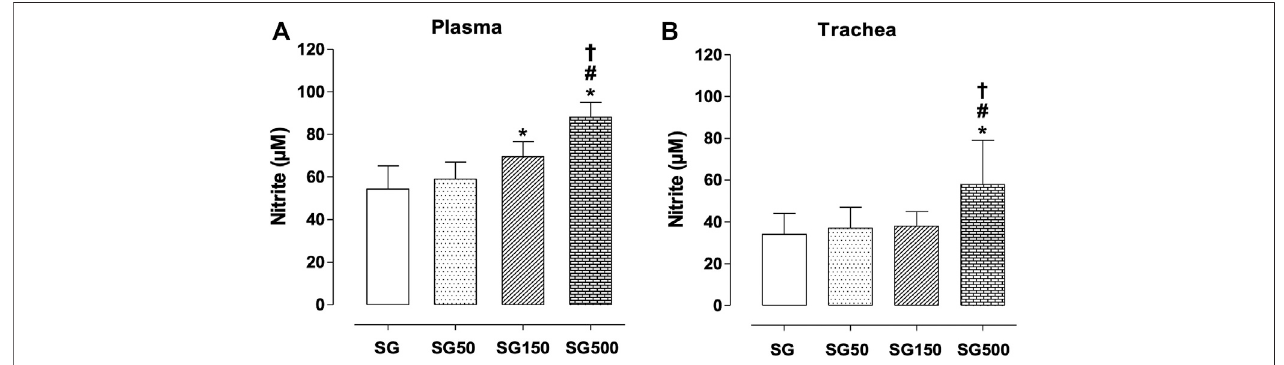
FIGURE 6 | Percentage of oxidation inhibition in blood plasma (A) , trachea (B) from SG (fx4), SG50 (fx5), SG150 (fx6), and SG500 groups (fx7). The columns and vertical bars represent the mean and S.D., respectively (n = 10). One-way ANOVA followed by Bonferroni ’ s post-test. * p < 0.05 (SG vs . SG150 and SG500), # p < 0.05 (SG50 vs . SG500) and † p < 0.05 (SG150 vs . SG500). Healthy saline group = SG. Healthy group supplemented with S. platensis at 50, 150, and 500 mg/kg = SG50, SG150, and SG500,